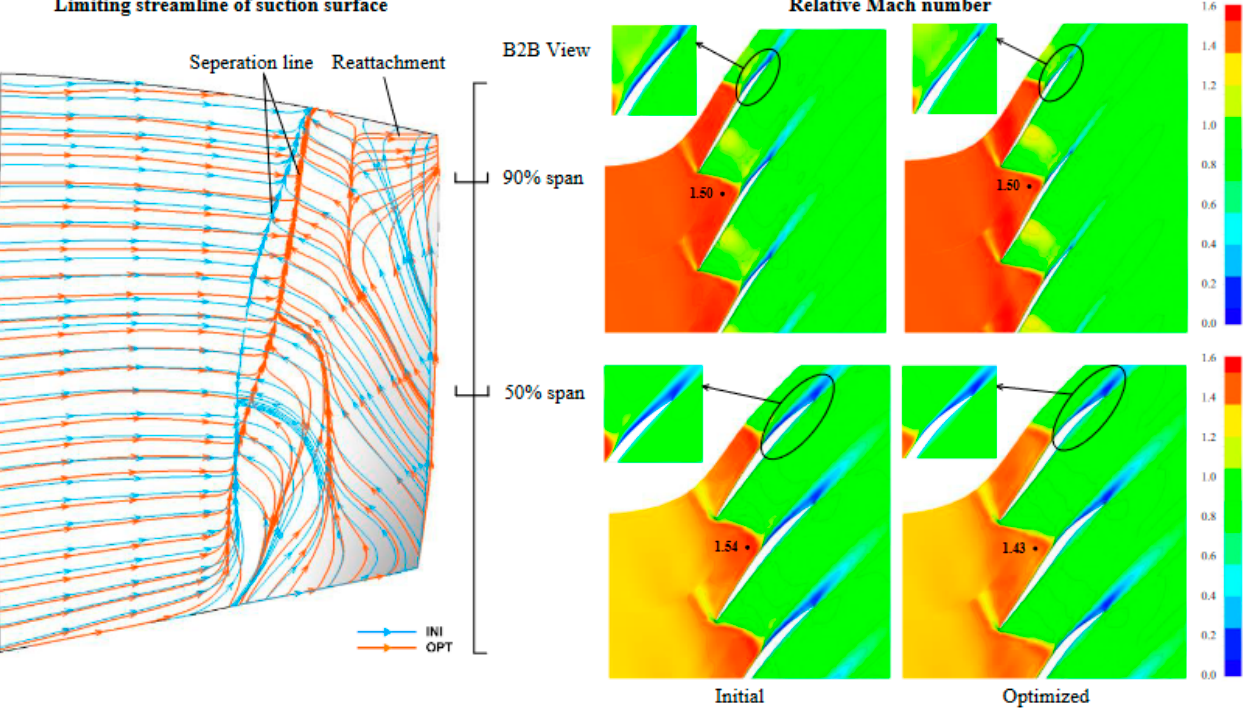
Figure 13. The limiting streamline and the relative Mach number distribution of the initial and optimized blade.